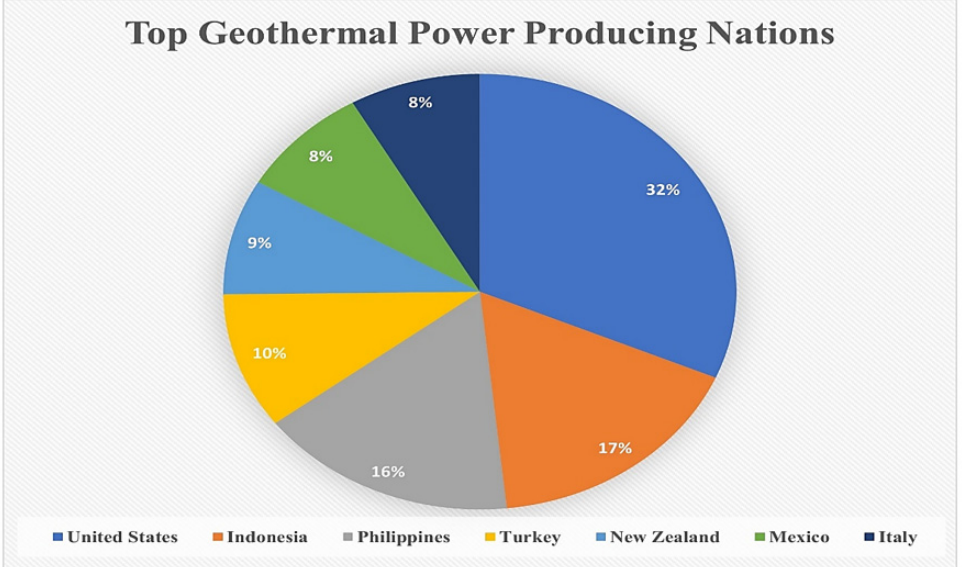
Figure 5. Pie chart depicting top geothermal power-producing nations globally. Source: Indonesia Investments Report—July 2022 Edition (https://www.indonesia-investments.com/news/todays- headlines/indonesia-has-become-world-s-2nd-largest-geothermal-energy-producer/item8775, ac- cessed on 1 September 2022).